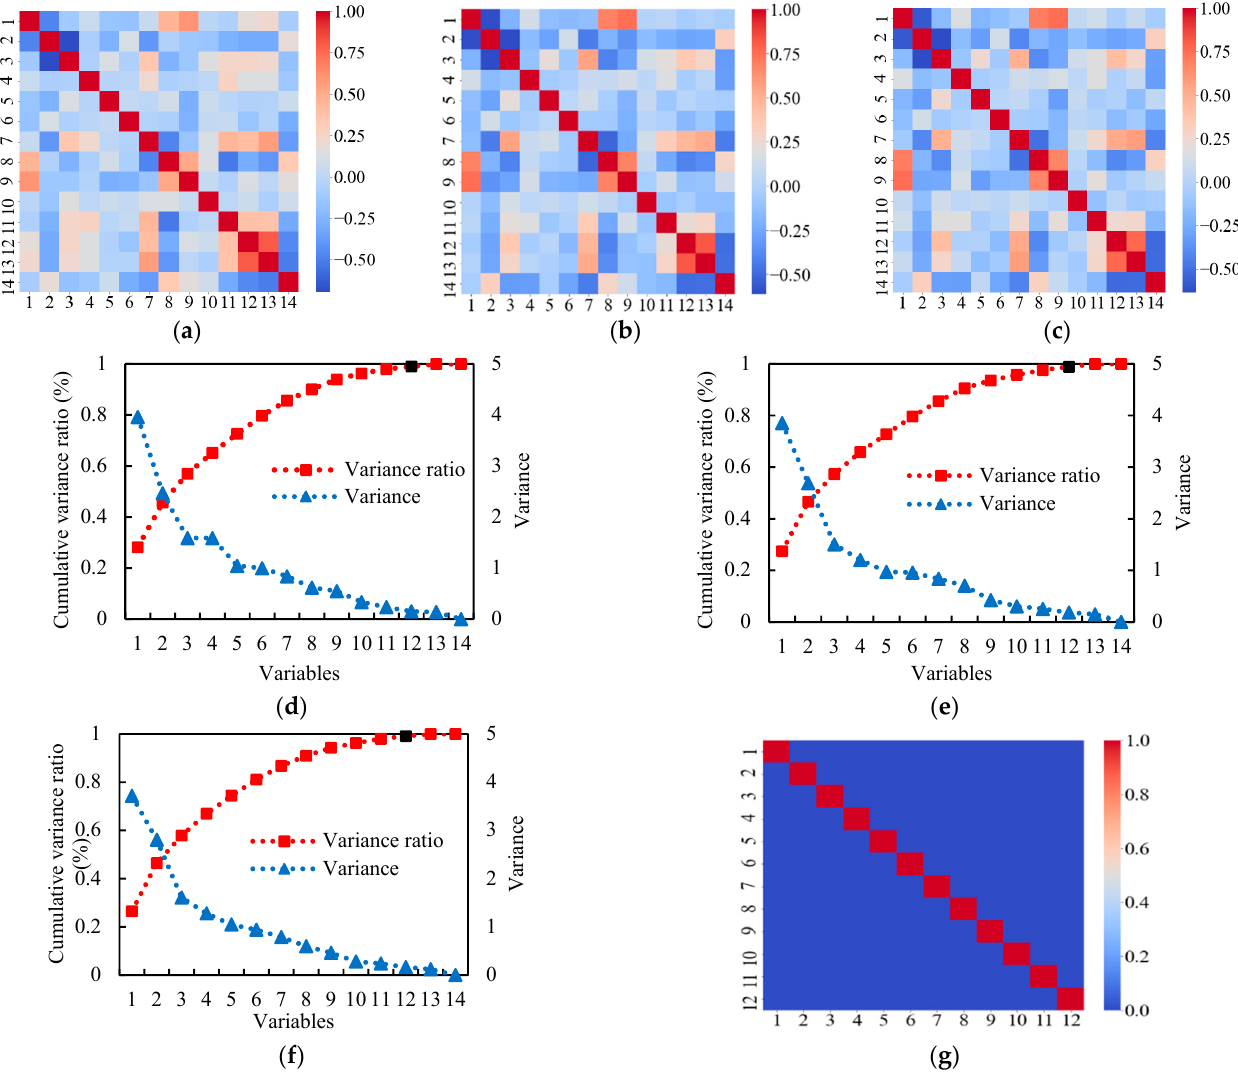
Figure 6. Multicollinearity analysis results. The correlation matrices for the compressive strength ( a ), tensile strength ( b ), and tensile strain capacity ( c ). Variance ratio and variance for the compressive strength ( d ), tensile strength ( e ), and tensile strain capacity ( f ). The correlation matrix for each pair of variables after PCA is shown in ( g ). After the datasets are improved by the data cleaning and PCA, the datasets are used to train and test the machine learning models. Specifically, 75% of data are used for training, and 25% of data are used for testing of the machine learning models.